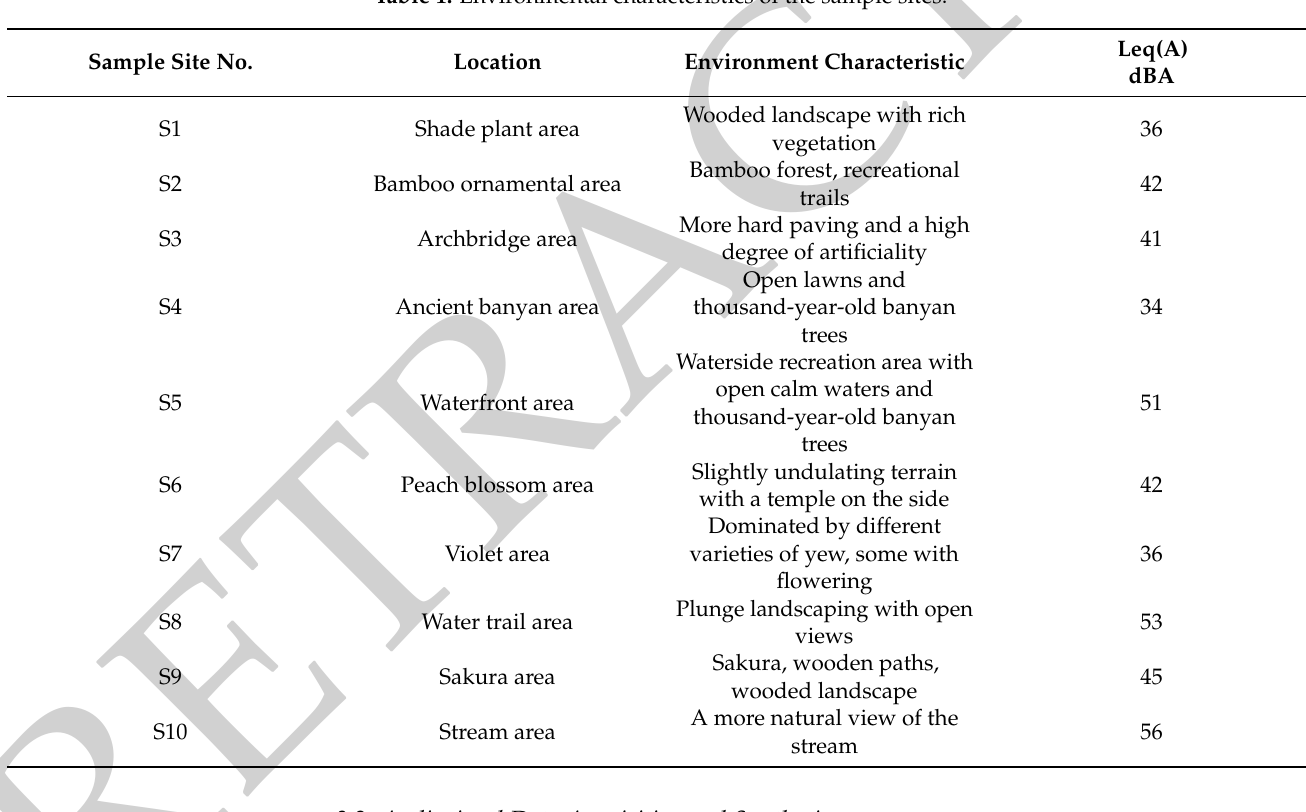
Table 1. Environmental characteristics of the sample